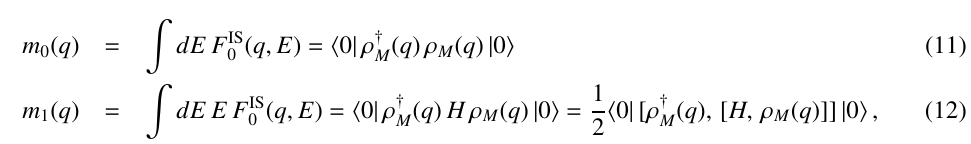
Table 1. Relative contribution of resonance strength